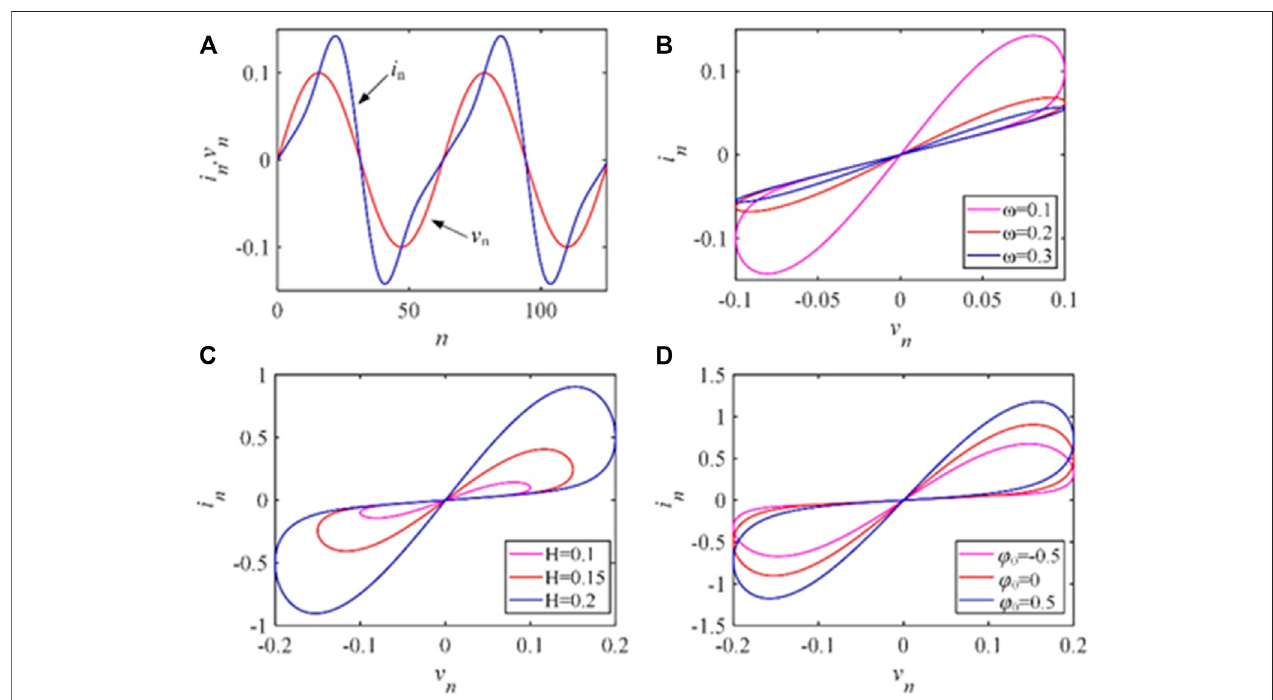
FIGURE 1 | Characteristics of the discrete memristor when being applied to a discrete sinusoidal current i n = H sin ( ω n), where α = 0.5 and β = 0.5. (A) Current and voltage sequences; (B) H = 0.1, φ 0 = 0; (C) ω = 0.1, φ 0 = 0; (D) H = 0.1, ω = 0.1.